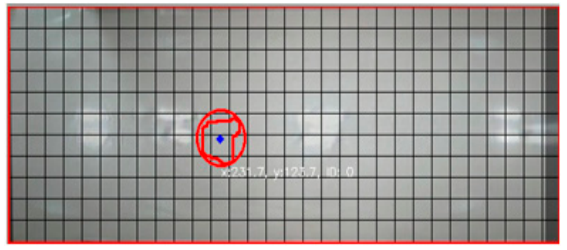
Figure 7. Two-dimensional map combined with the object area and the projected floor image.